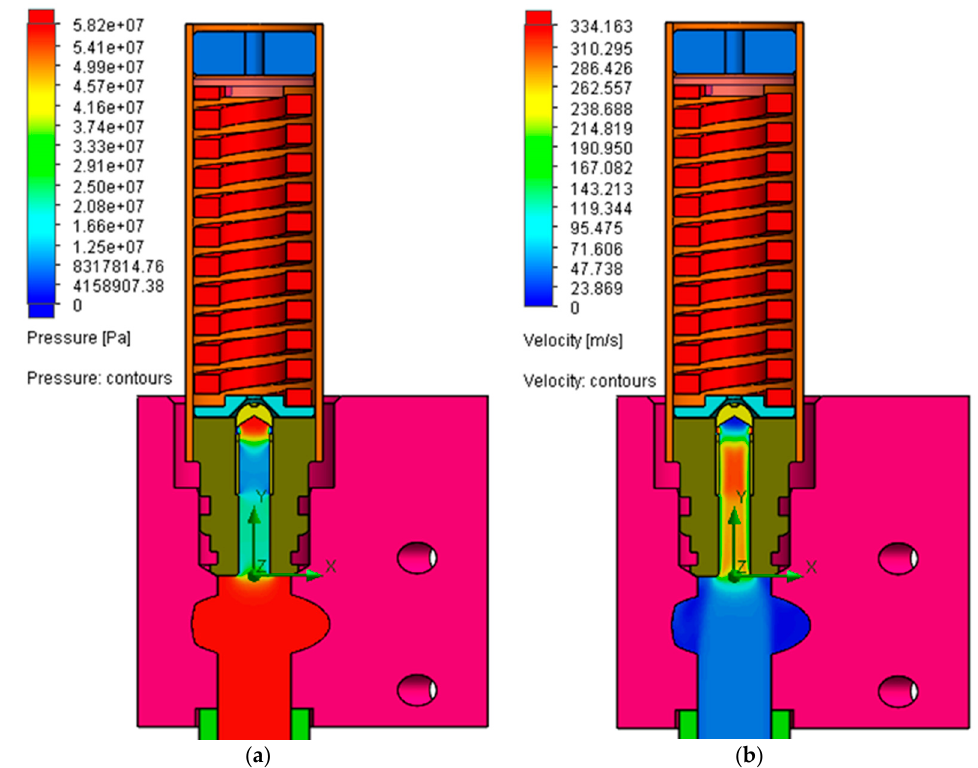
Figure 18. The variation maps of pressure ( p ) ( a ) and velocity ( υ ) ( b ) for a 0.01 m 3 ·s -1 volume flow rate (600 L·min -1 ).